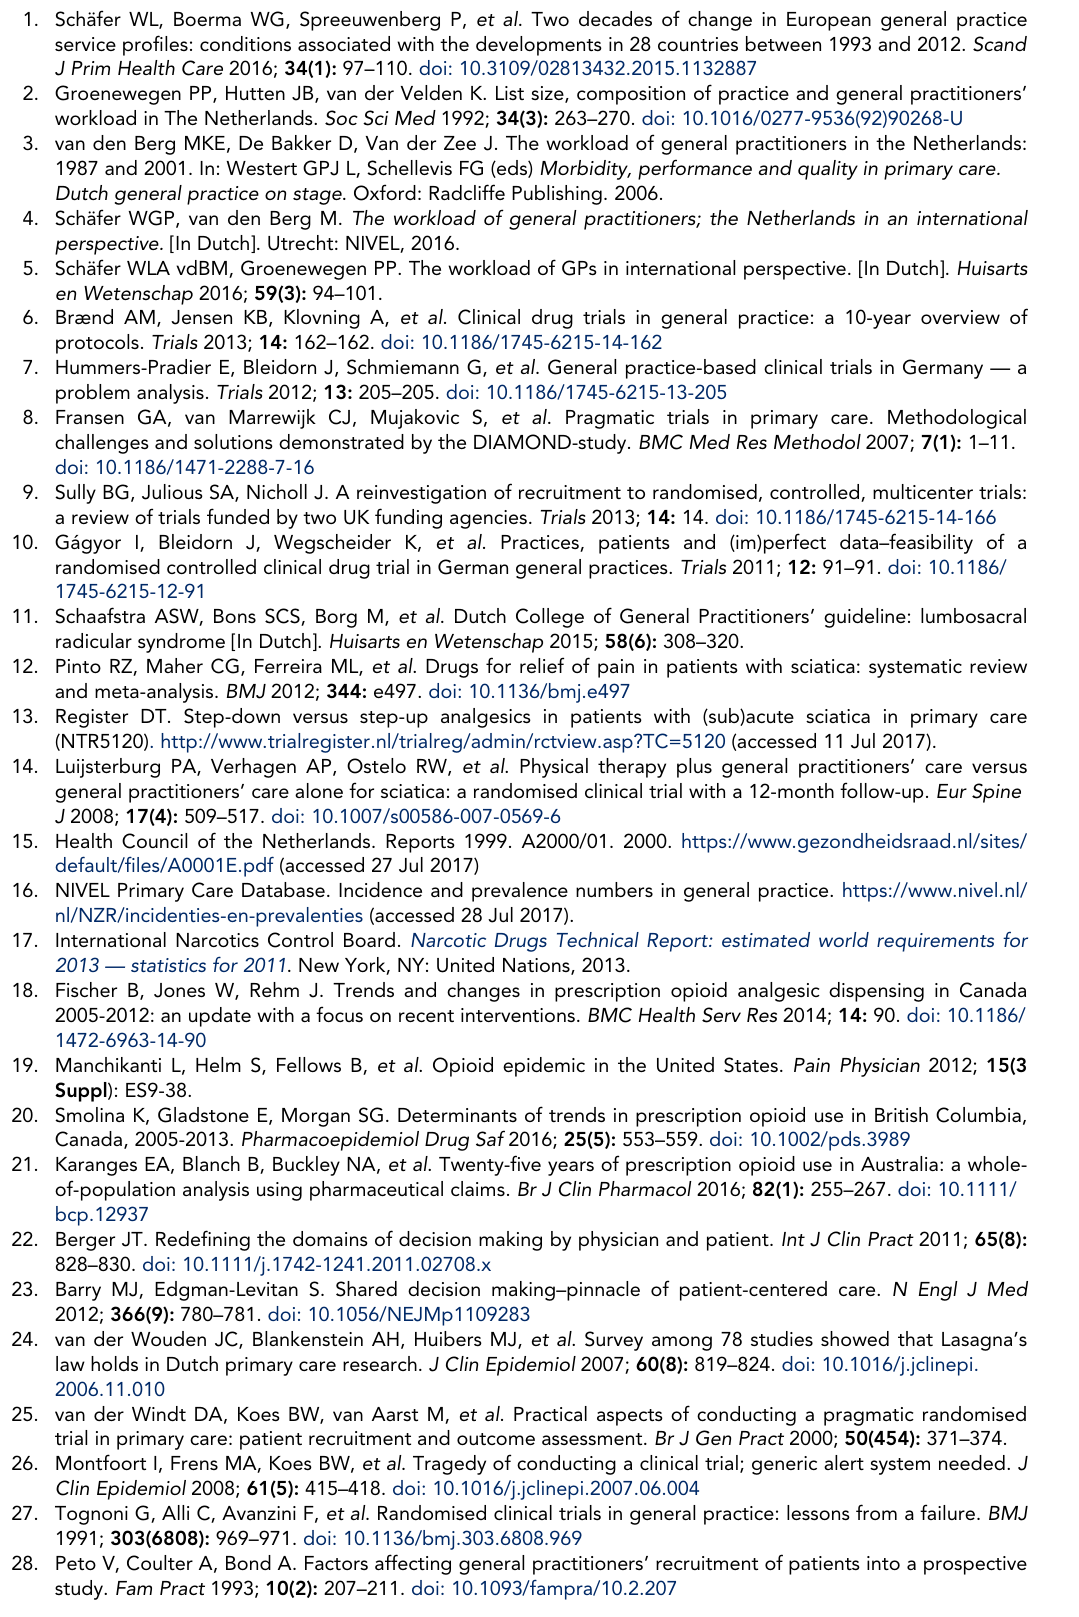
van der Gaag W H et al . BJGP Open 2017; DOI: